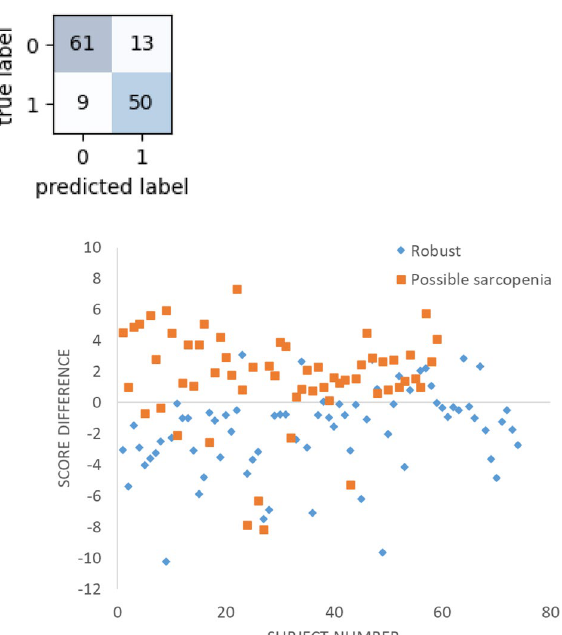
Figure 8. Results of score analysis of BPW indices for discriminating between robust (0) and possible sarcopenia (1). The accuracy, sensitivity, specificity, and AUC were 83.5%, 0.85, 0.82, and 0.83, respectively. Score difference (score1-score2) > 0 indicates robust characterization; score difference < 0 indicates possible- sarcopenia